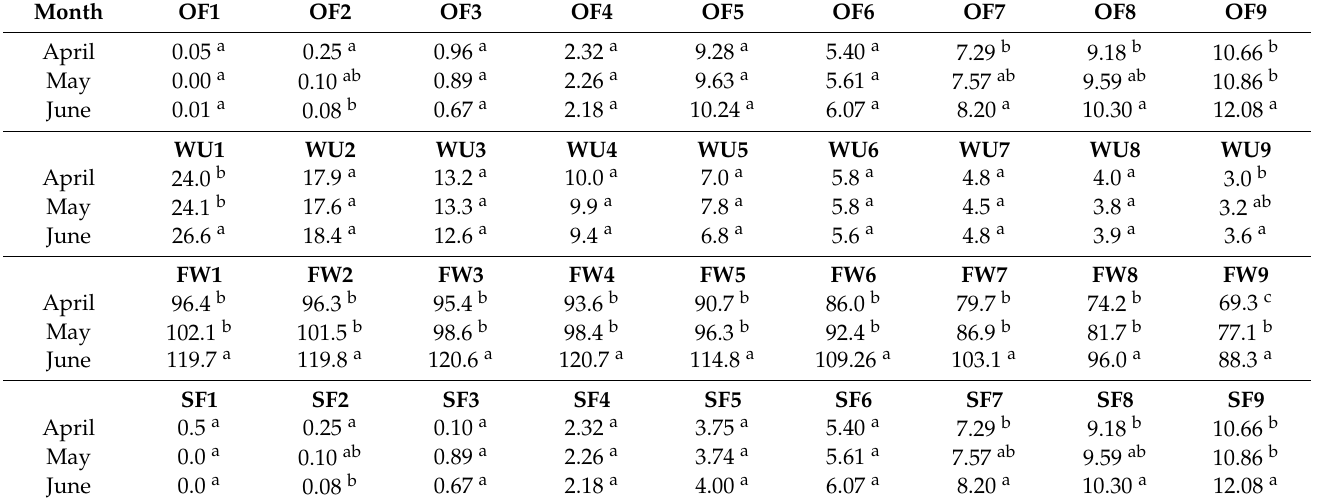
Table 4. Number of open flowers (OF), water uptake (WU, mL), flower fresh weight (FW, g), senescent flowers (SF) in a nine-day period (1–9) in vase of tuberoses planted on three planting dates: April,